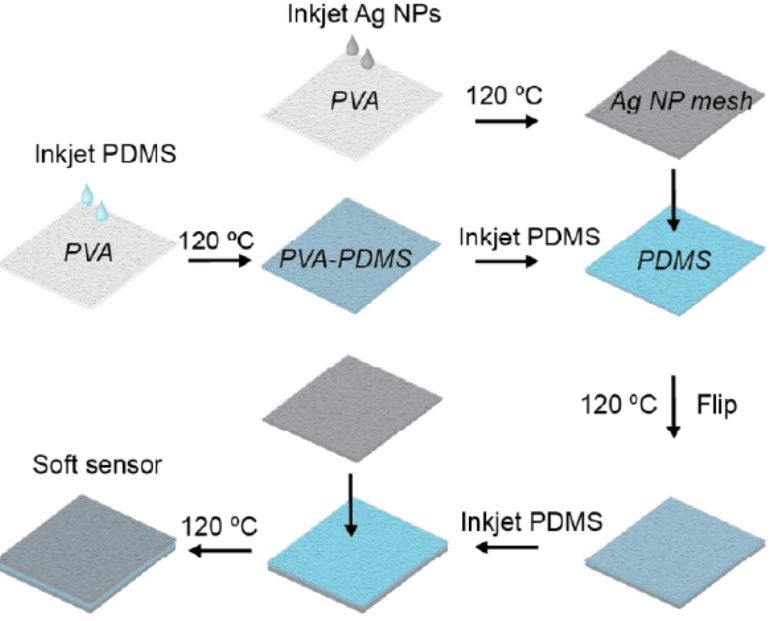
Figure 7. Schematic illustration of the sensor manufacturing process in [140].